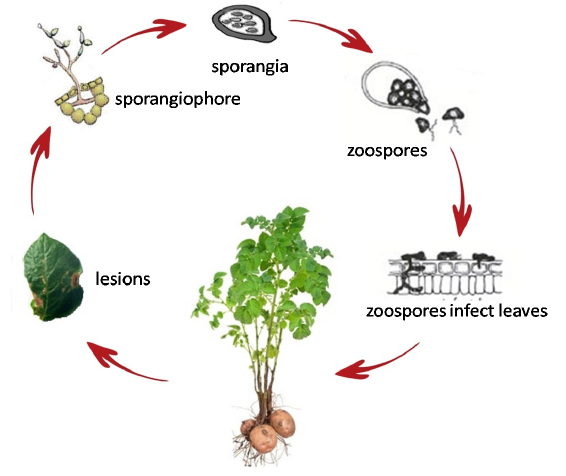
Figure 12. Phytophtora life